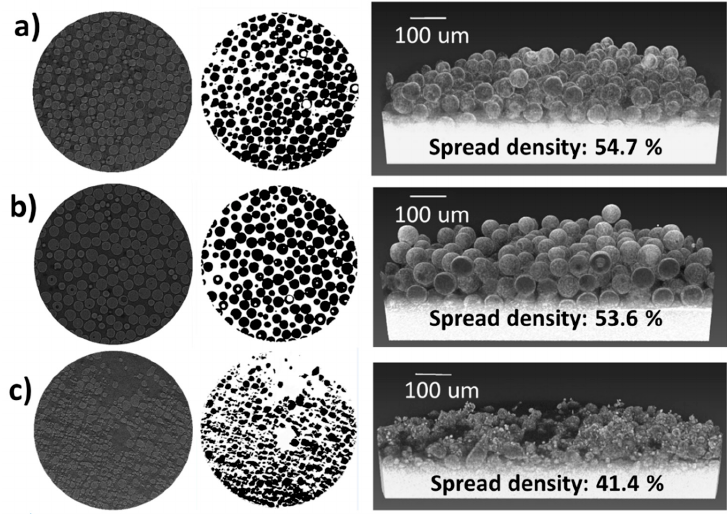
Figure 3. 2D and 3D reconstructed images of ( a ) powder A, ( b ) powder B, and ( c ) powder C used to determine the spread density.